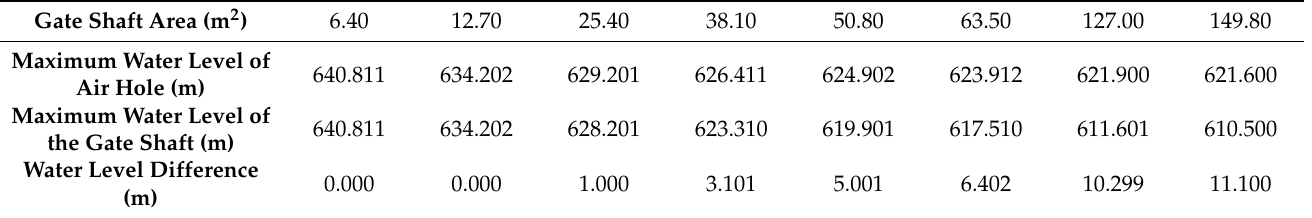
Table 7. Maximum water level of the gate shaft and air hole (increasing the gate shaft